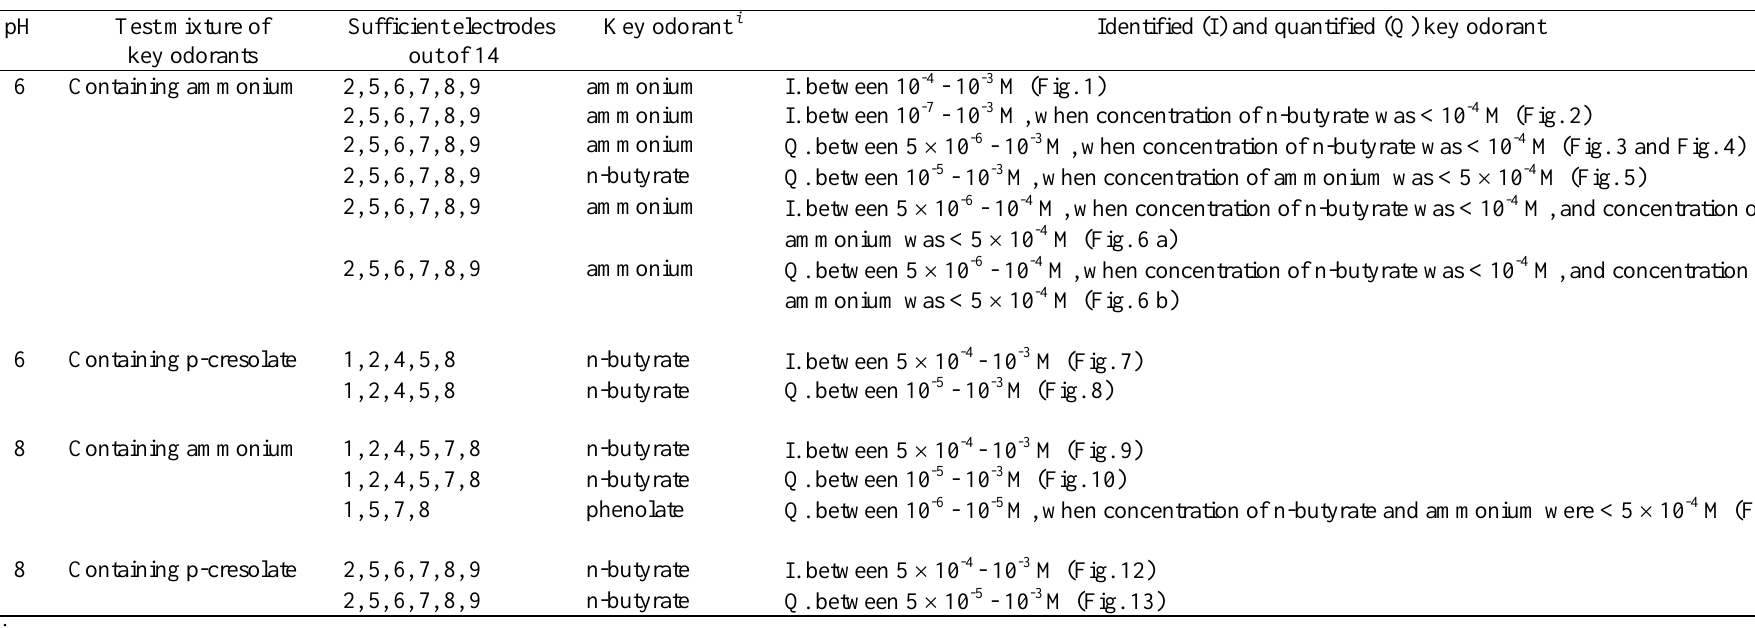
Table 4 . Summary of results for different test mixtures of key odorants at pH 6 and pH 8.